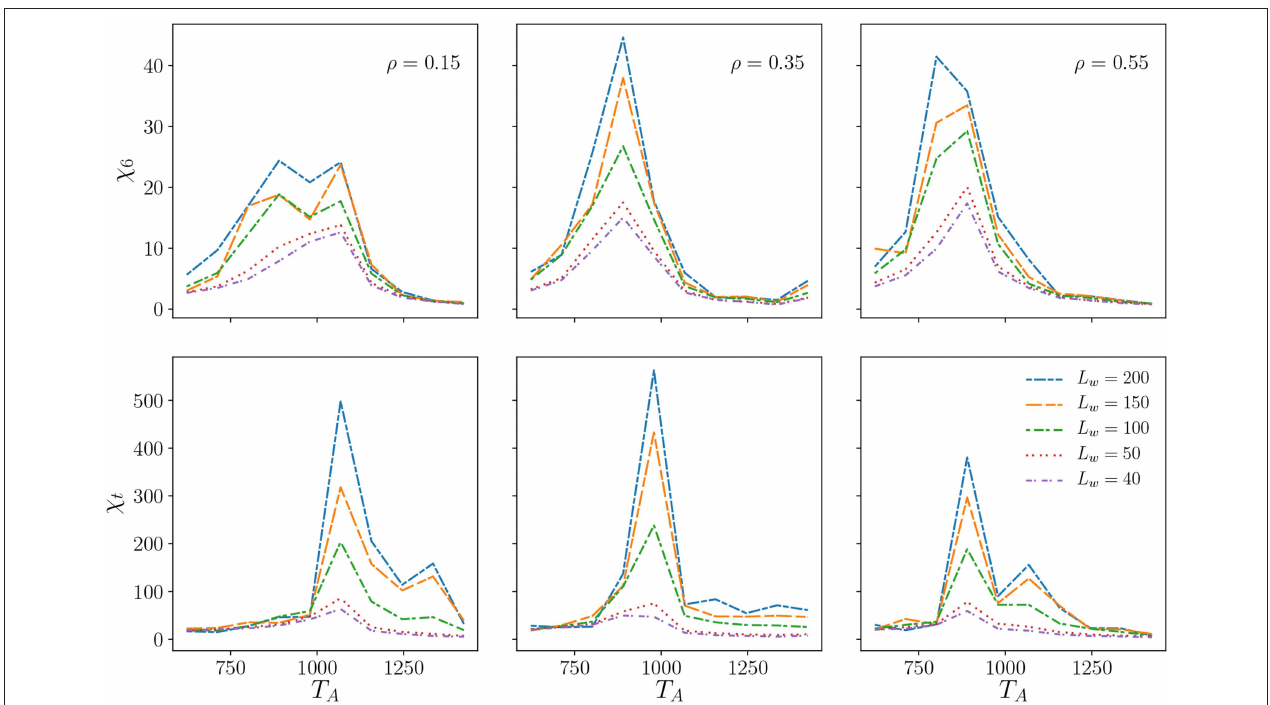
FIGURE 6 | The susceptibilities χ 6 and χ t of the global order parameters 9 6 , 9 t , respectively. A system with parameters L square subdomains of widths L w . For each of these subdomains the global order parameters and the susceptibilities are computed and then a variance of those measurements is